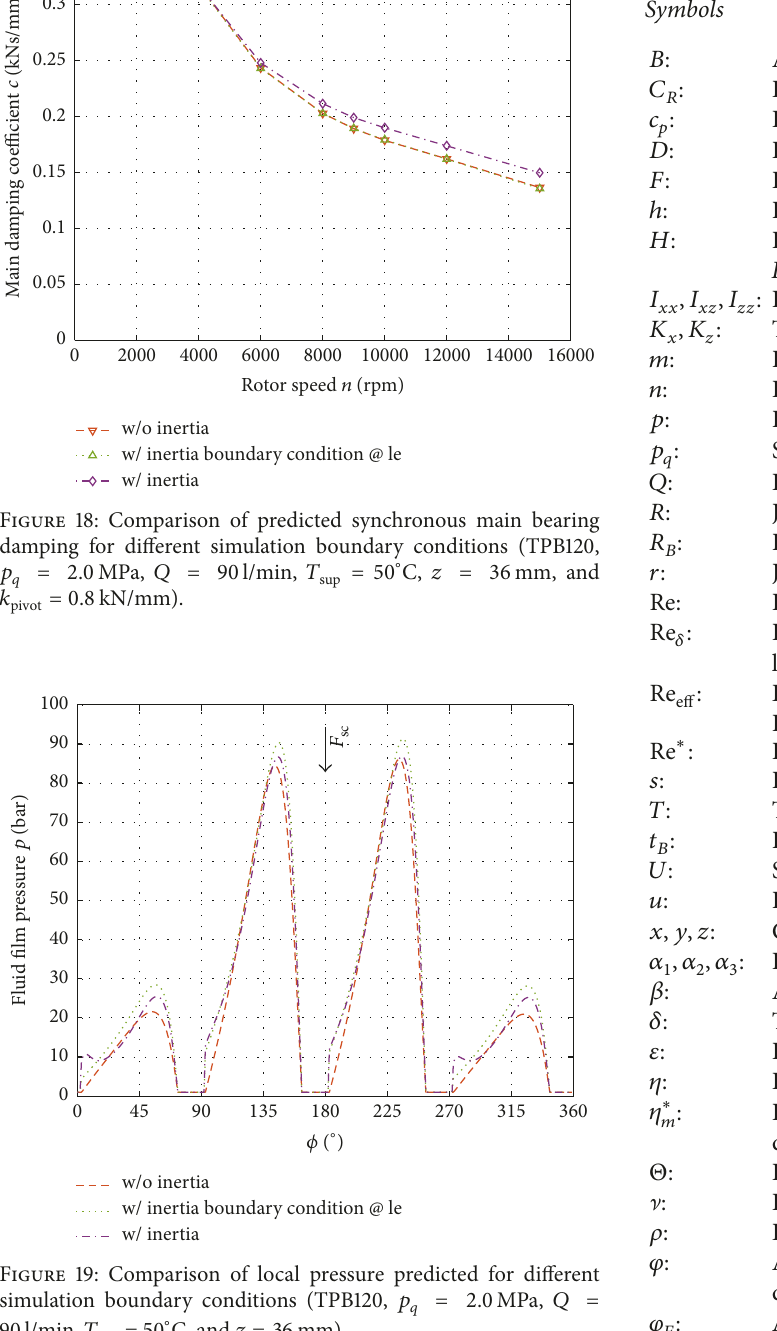
Figure 19: Comparison of local pressure predicted for different simulation boundary conditions (TPB120, 𝑝 𝑞 = 2.0 MPa, 𝑄 = ∘ C, and 𝑧 = 36 90 l/min, 𝑇 sup = 50